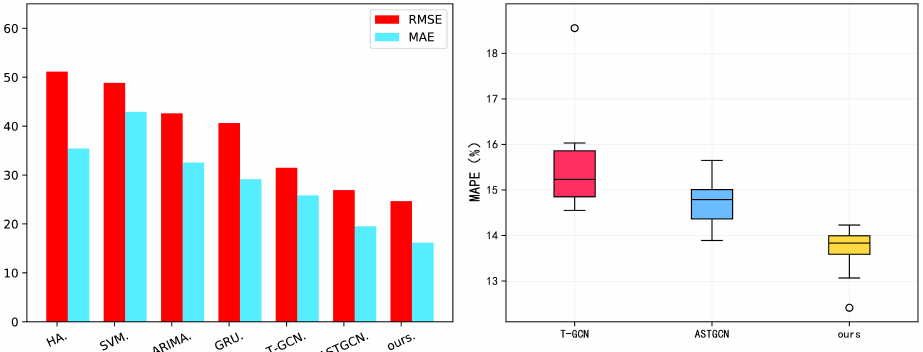
Figure 8. Performance comparison charts. The left subfigure is the bar chart, and the right subfigure is the box chart.